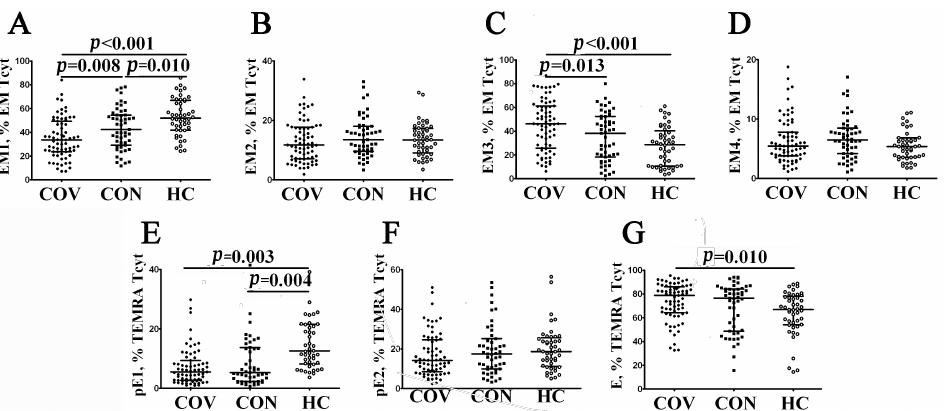
Figure 5. Alterations in relative number of EM and TEMRA CD8+ T cell subsets with Figure 5. 5